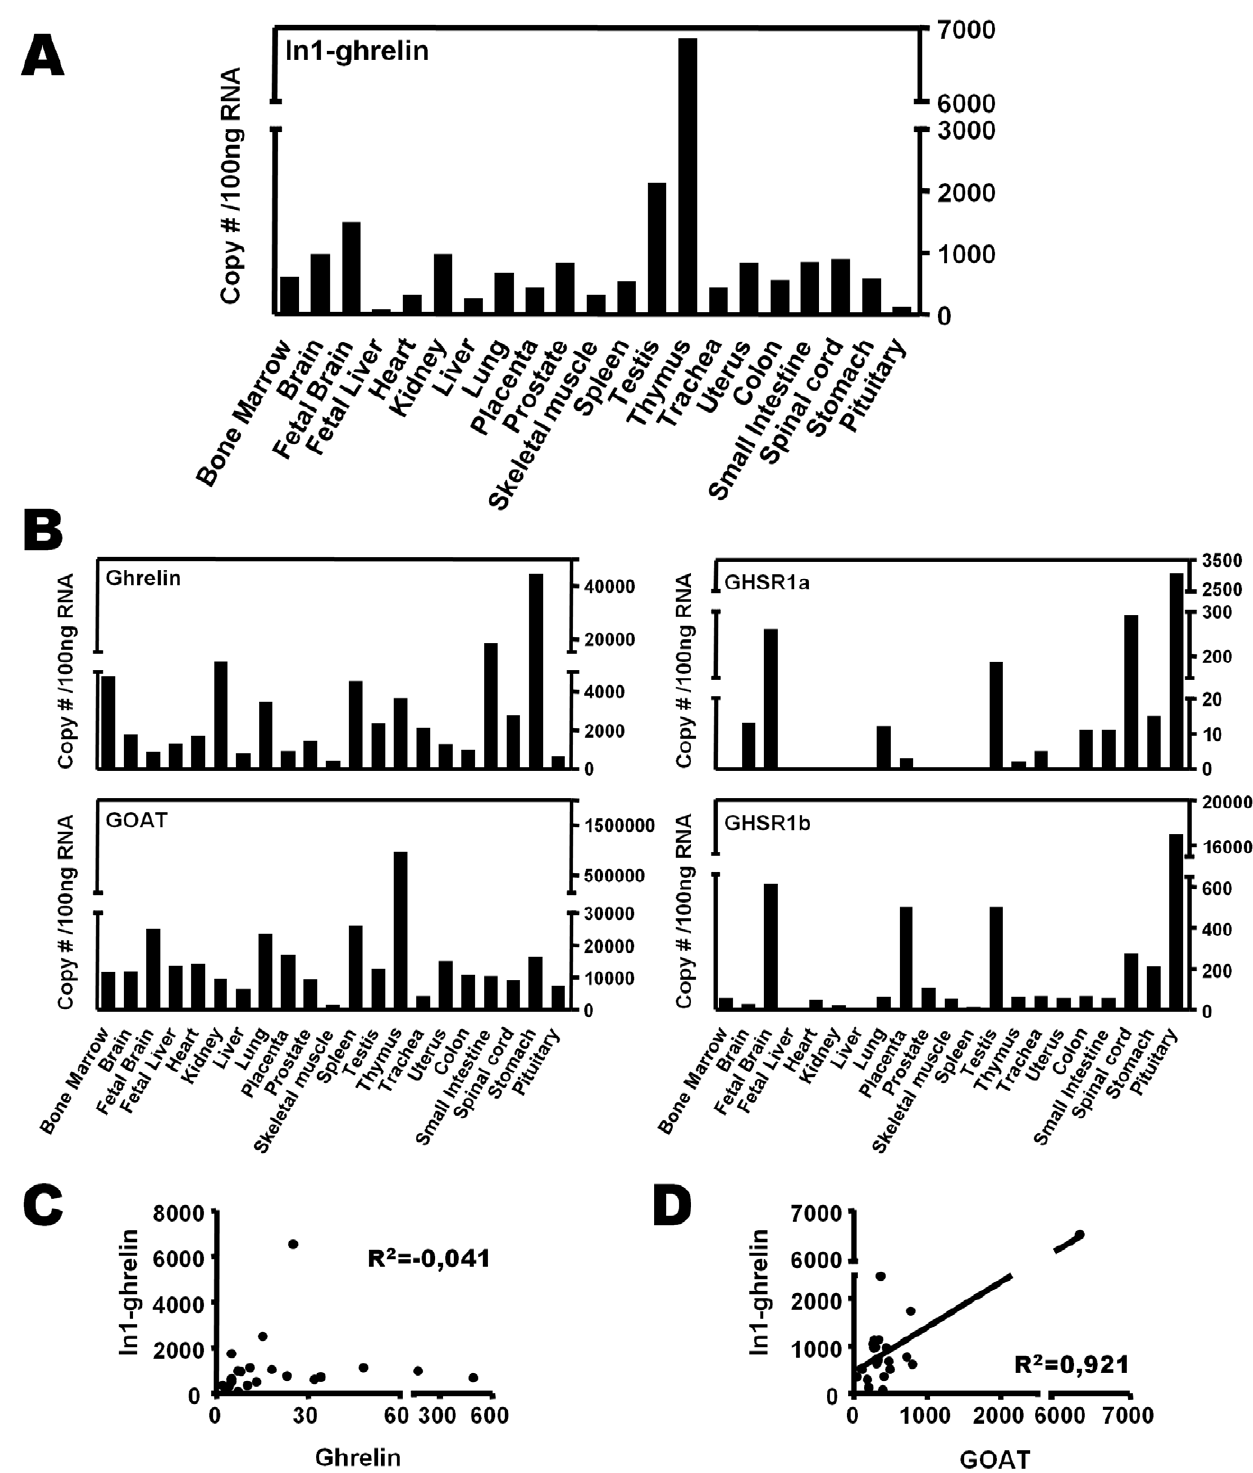
Figure 2. Tissue distribution of the human In1-ghrelin variant. (A) Quantitative (qrtPCR) expression levels of In1-ghrelin using a commercial panel of total RNA from various human tissues obtained from Clontech, where each tissue sample is a pool of multiple individuals and represents a mean expression level in this particular tissue (only a single sample of each tissue is provided). (B) Quantitative (qrtPCR) expression levels of ghrelin, GOAT, GHSR1a and GHSR1b using the same commercial panel of total RNA from various human tissues obtained from Clontech. (C) Correlation between In1-ghrelin and native ghrelin expression in human tissues (G) Correlation between In1-ghrelin and GOAT expression in human tissues.